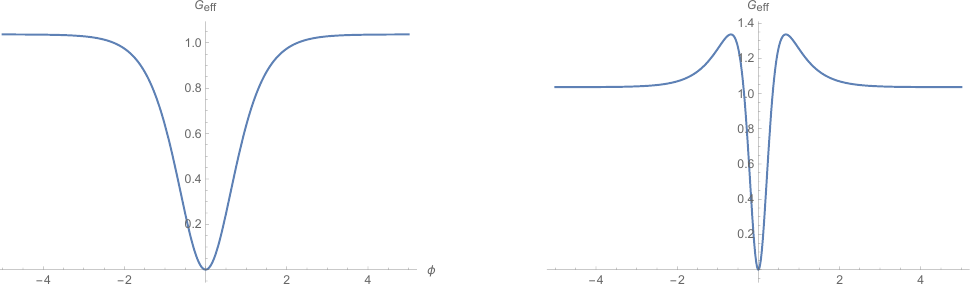
Figure 3. The effective gravitational constant as a function of relational time φ for E < 0 to the left and E > 0 to the right given in arbitrary units, taken from Ref. [54]. A bounce occurs towards φ = Φ situated at the origin of both plots. For large φ Newton’s constant is asymptotically attained. In the plots and in this caption the label j is